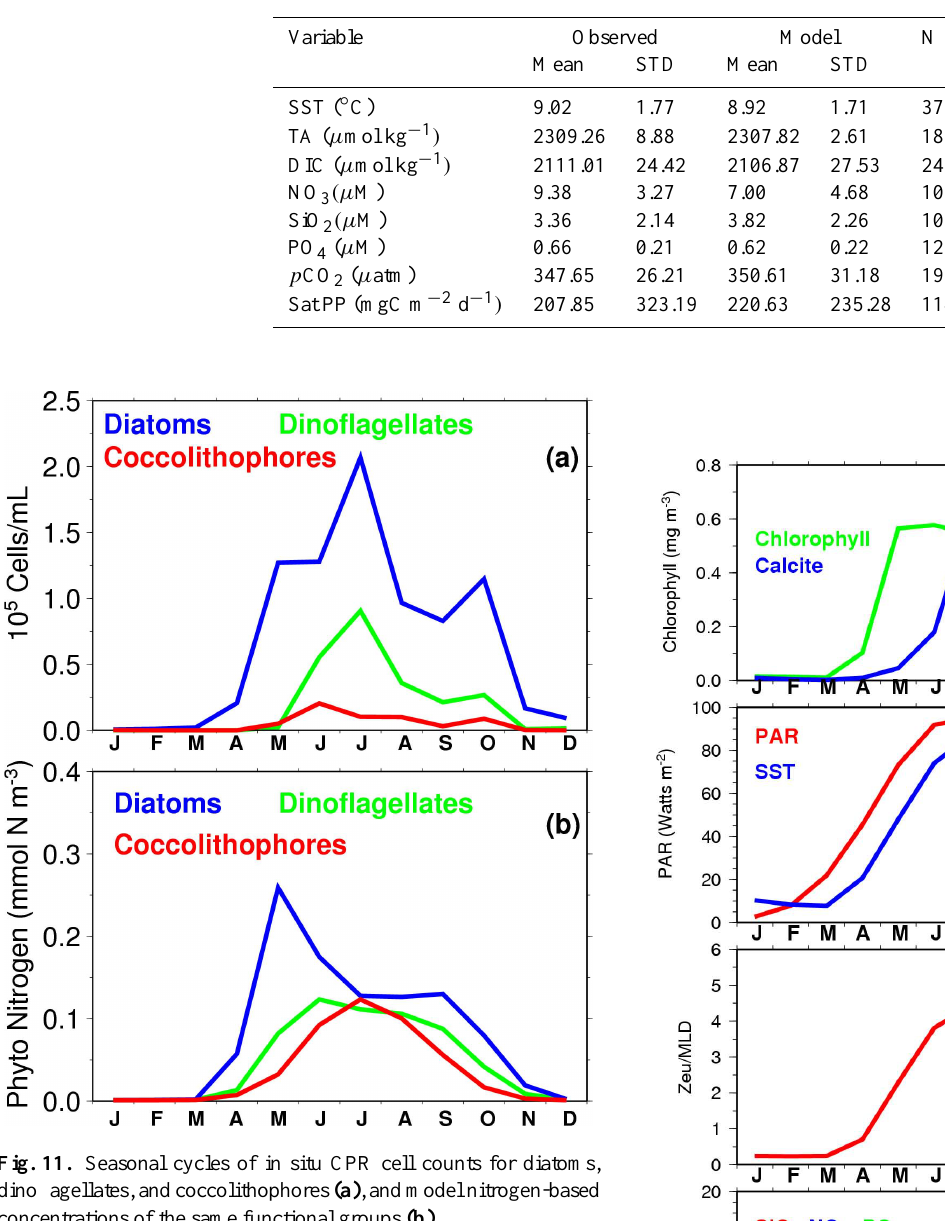
Table 2. Summary of surface-ocean observed and model (reference run) mean values and standard deviations (STD) for a selected number of variables. Only daily model values matching the nearest observed dates were included.